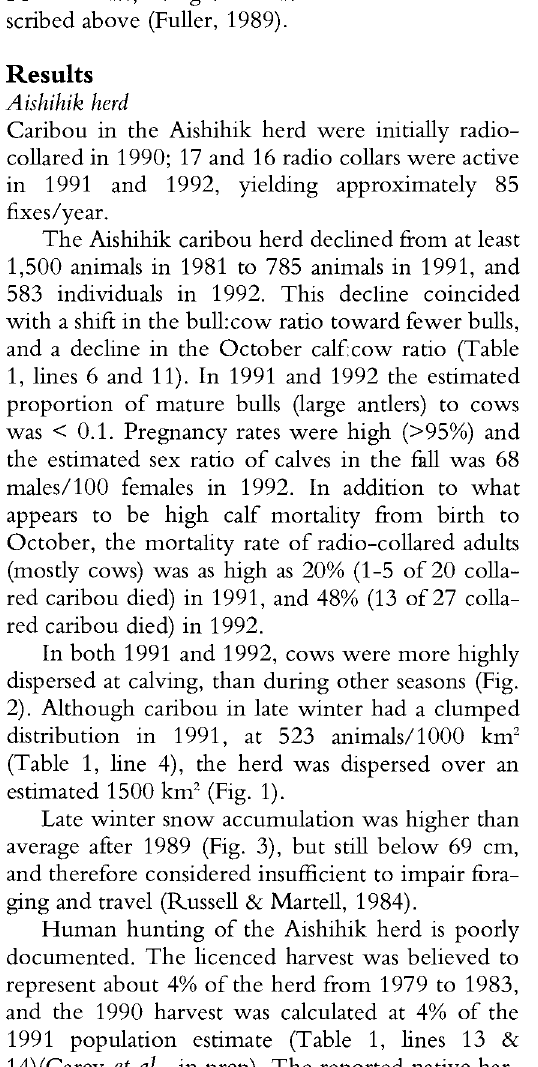
Fig. 2. Average distances between radio-collared caribou against season, for the Aishihik and Wolf Lake caribou herds.